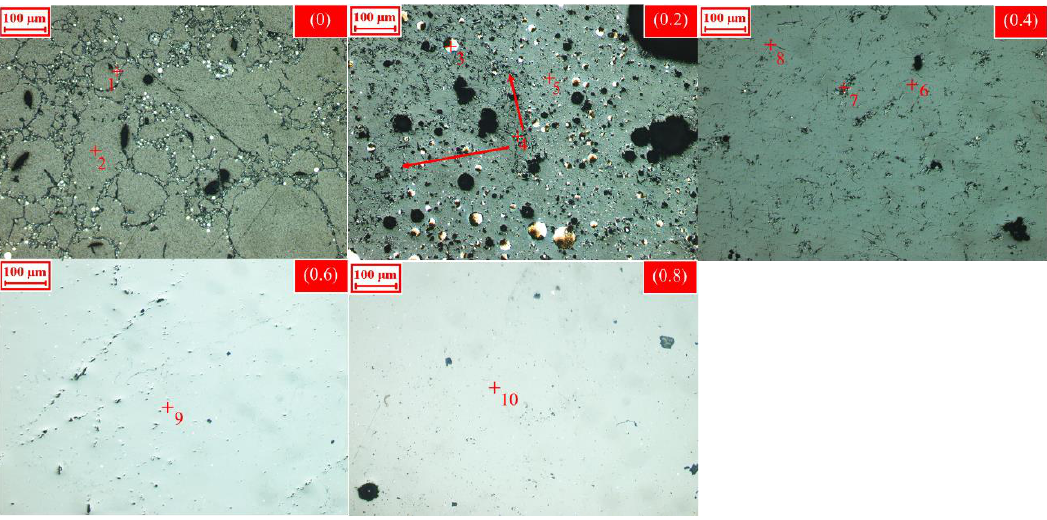
Figure 13. XRD patterns of the slag obtained from smelting separation at different basicity levels. Table 7. The content of main compositions in the slag of Figure 13 (wt. %).